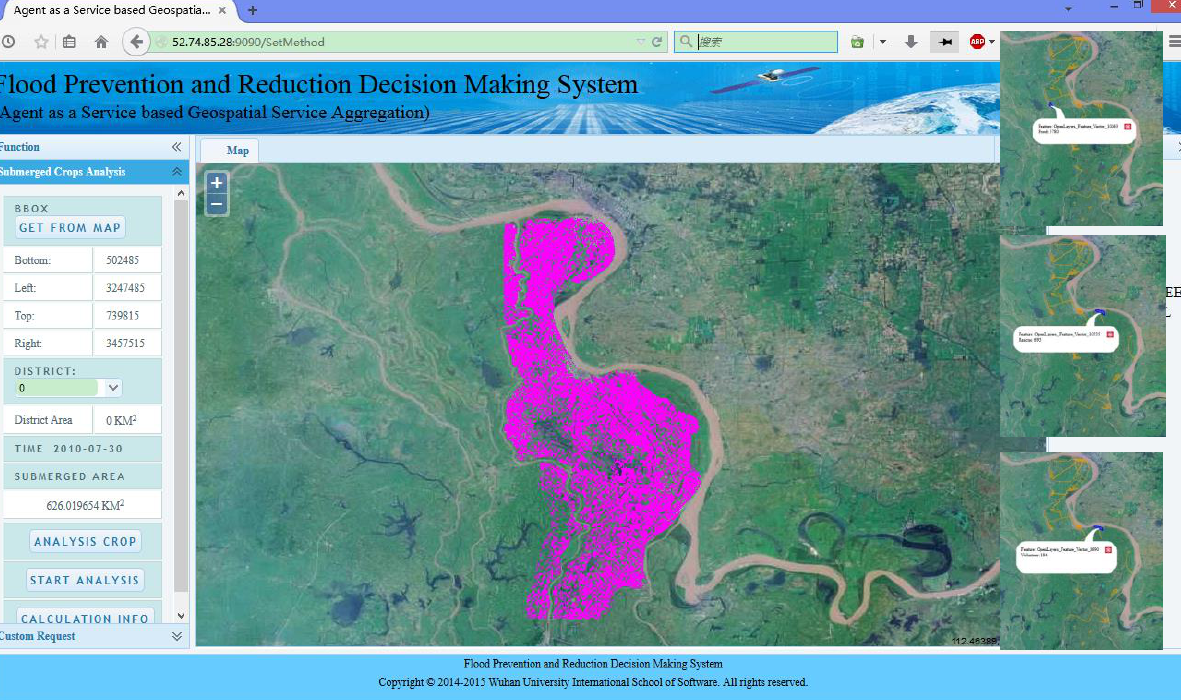
Figure 3 Flood Response Prototype